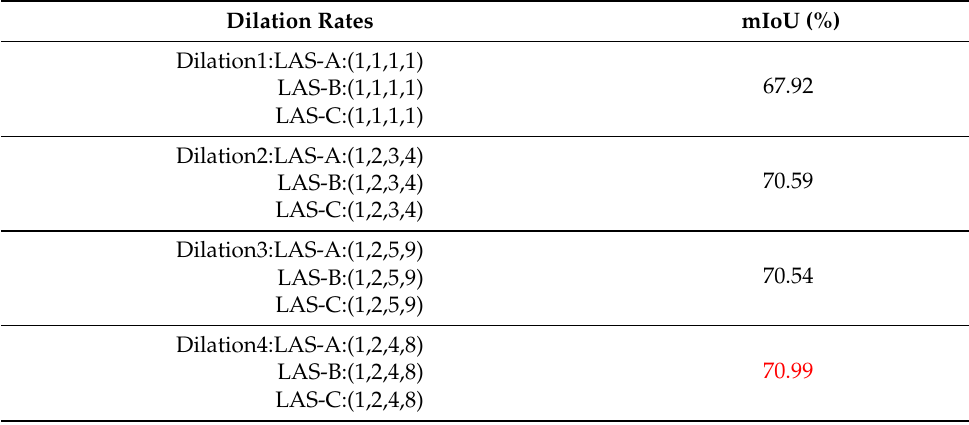
Table 6. Ablation studies of different dilation rates. The red color font indicates the optimal